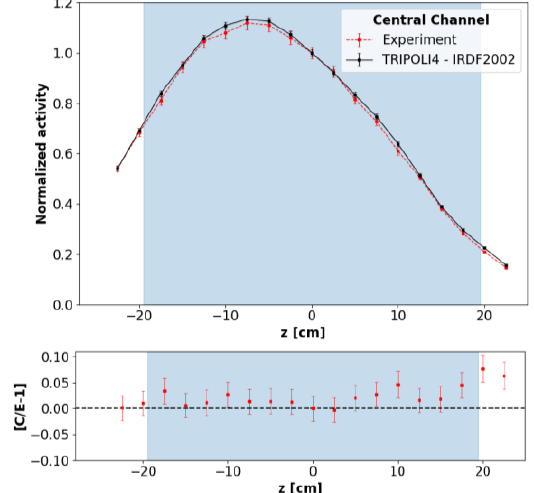
Fig. 9. Measured and calculated axial profile of 197 Au(n, γ) 198 Au reaction rates in the reactor core central channel normalized to the maximal value. The error bars represent the 1σ uncertainty. Area marked in blue denotes the active fuel region of the standard fuel element.